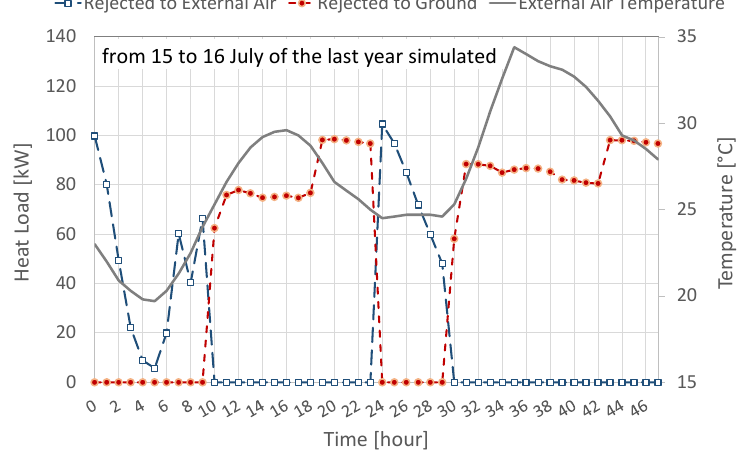
Energies 2020 , 10 , x FOR PEER REVIEW Figure 7. Ground heat extraction–injection rate in each simulated scenario. Figure 7. Ground heat extraction–injection rate in each simulated scenario.